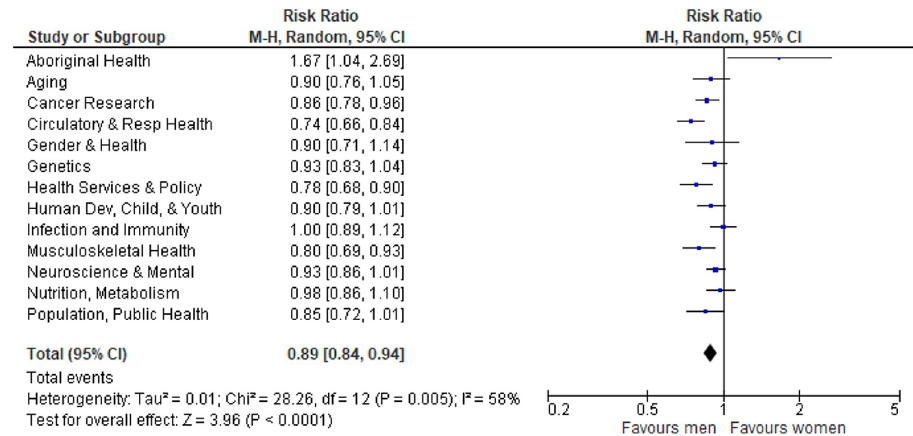
Fig 3. Forest plot of gender differences in grant success rates by designated research institute. CI, confidence interval; M-H, Mantel Haenszel.